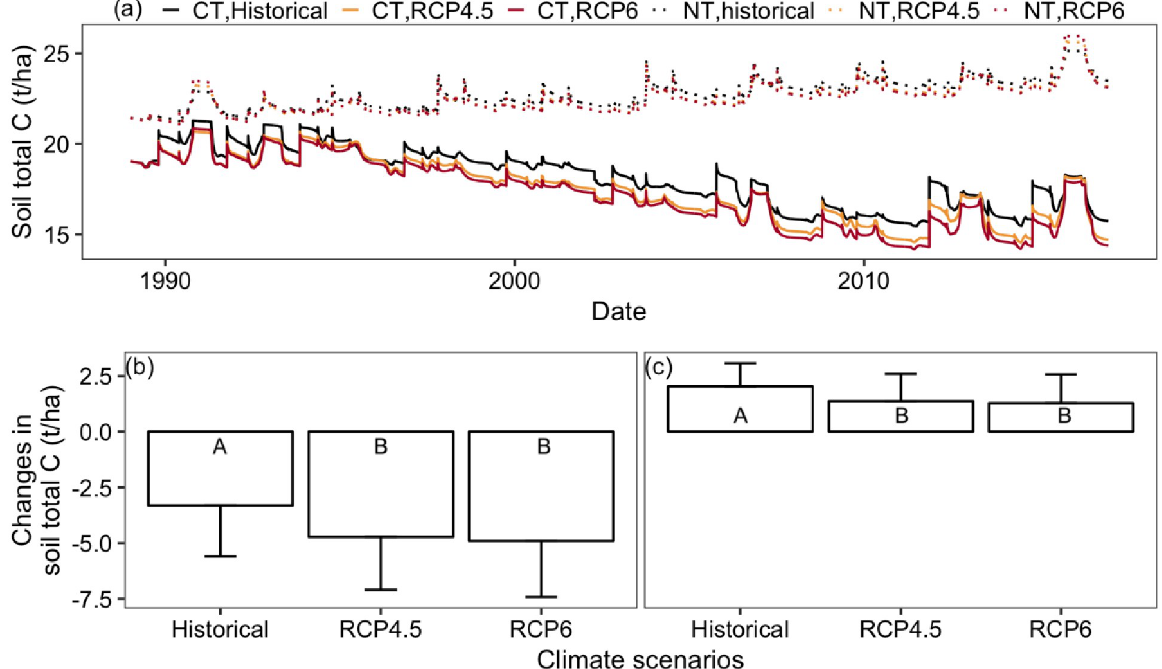
Fig 7. (a) Average SOC across the six replicates under the two treatments, conventional tillage (CT) and no-till (NT), during the simulated 28 years for historical, RCP4.5 and RCP6 climates; (b) Average and standard deviation of SOC loss in the simulated 28 years under conventional treatment; (c) Average and standard deviation of SOC gain in the simulated 28 years under no-till treatment (bars represent the standard deviation values; climate scenarios sharing the same letter are not significantly different at P = 0.05 using Tukey’s honestly significant difference